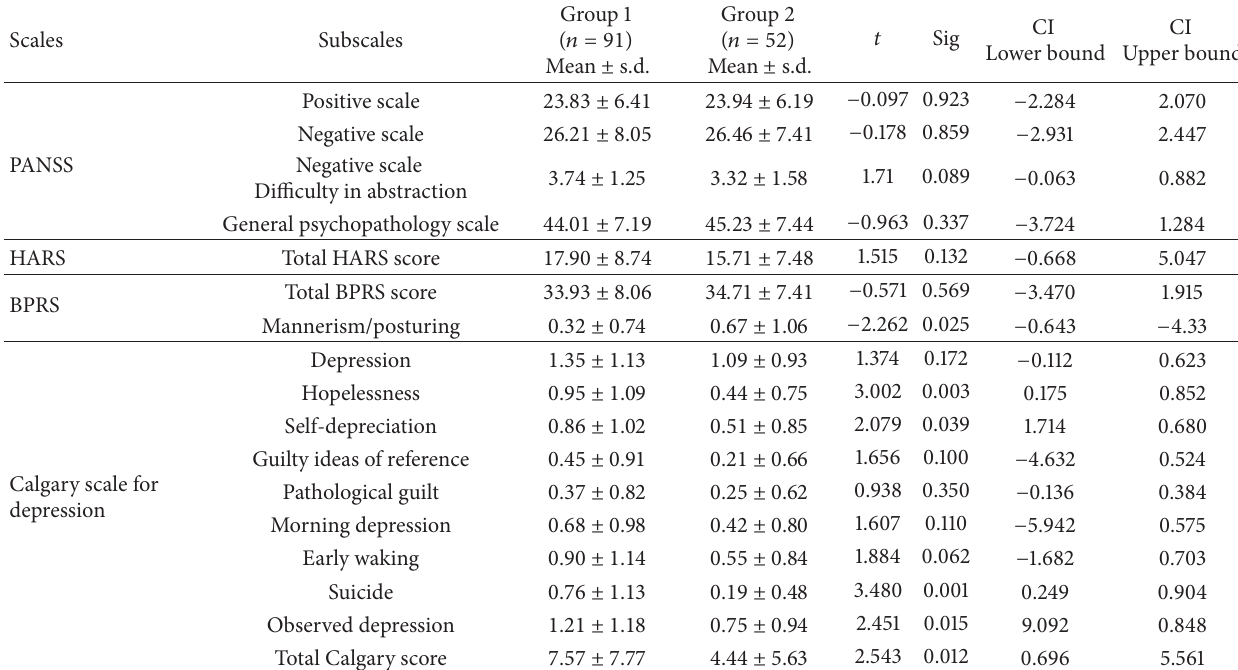
Table 2: PANSS, HARS, and BPRS and Calgary scale for depression scores at baseline in schizophrenia patients with substance use disorder (Group 1) and without substance use disorder (Group 2).